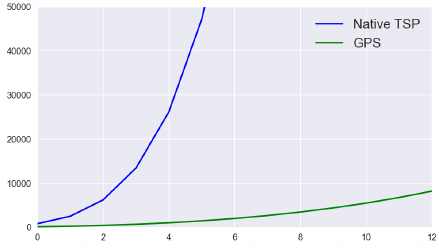
Figure 8. In this figure we can appreciate the exponential behaviour and the number of interconnec- tions that each model offers. Our model (GPS) improves the number of qubits and gives us a great result reducing the number of connections a lot. The Native_TSP behaves as 0.8 ( N + 2 ) 5 while the GPS as 2 ( N + 2 ) 3 .